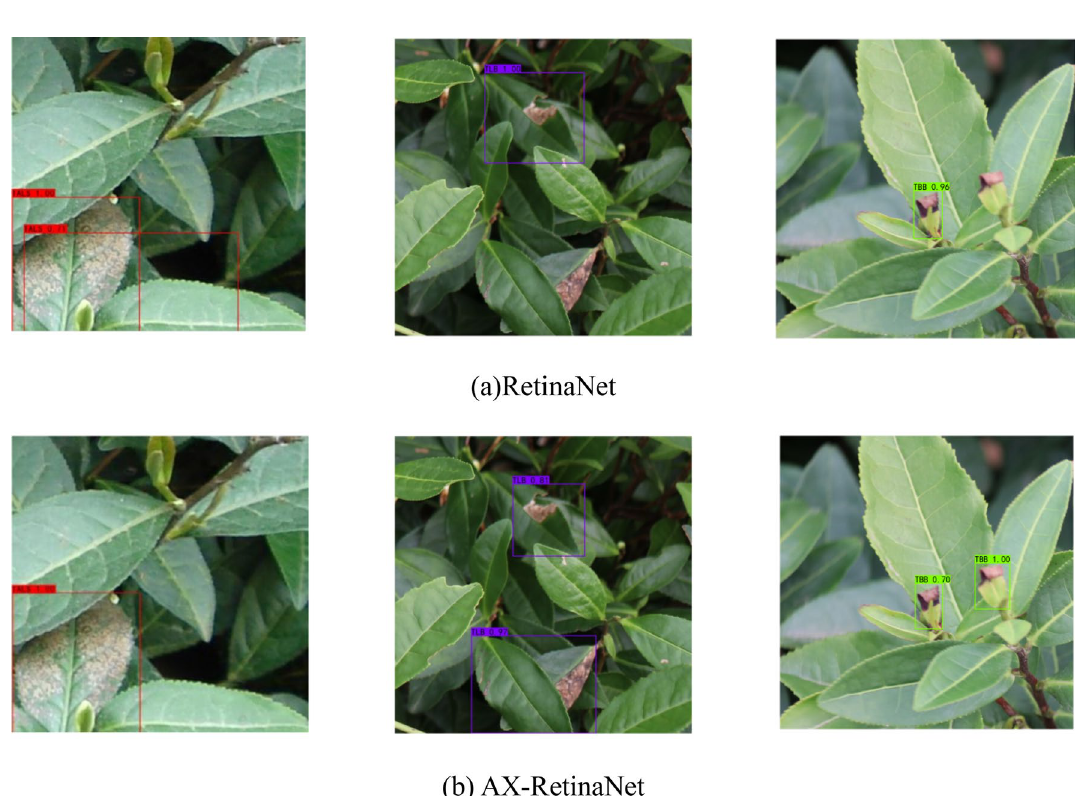
Figure 12. Some of the detection and identification results of AX-RetinaNet and